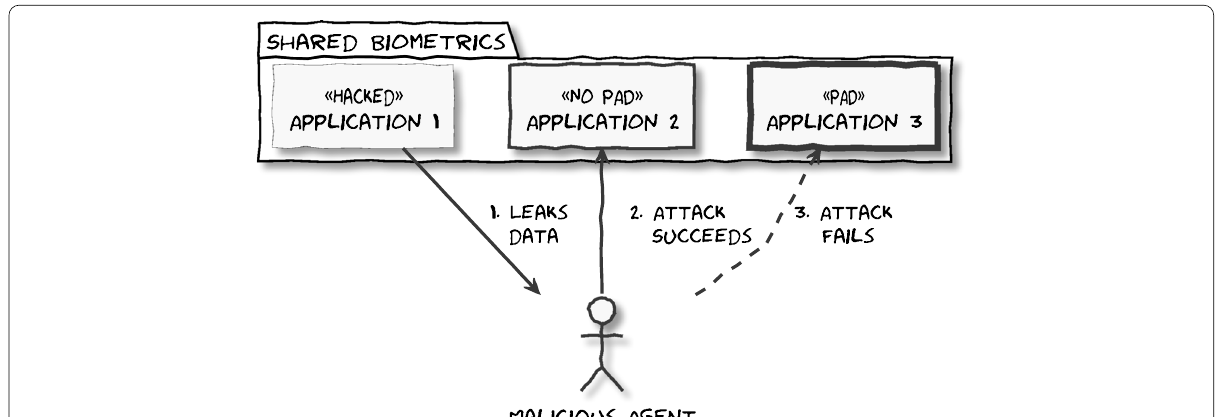
Fig. 1 A selection of three applications that all share the same biometric source. Application 1 is lacking in security and leaking data to a malicious agent. This agent attempts to use said data on an application 2 without PAD and succeeds. It further attempts to use the data on an application 3 with PAD and